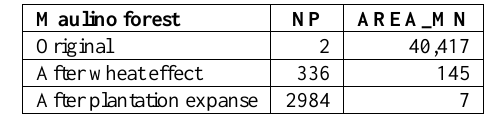
Table 6 . Maulino forest landscape metrics for three historic moments: Patch Number (NP) and Mean Patch Area in